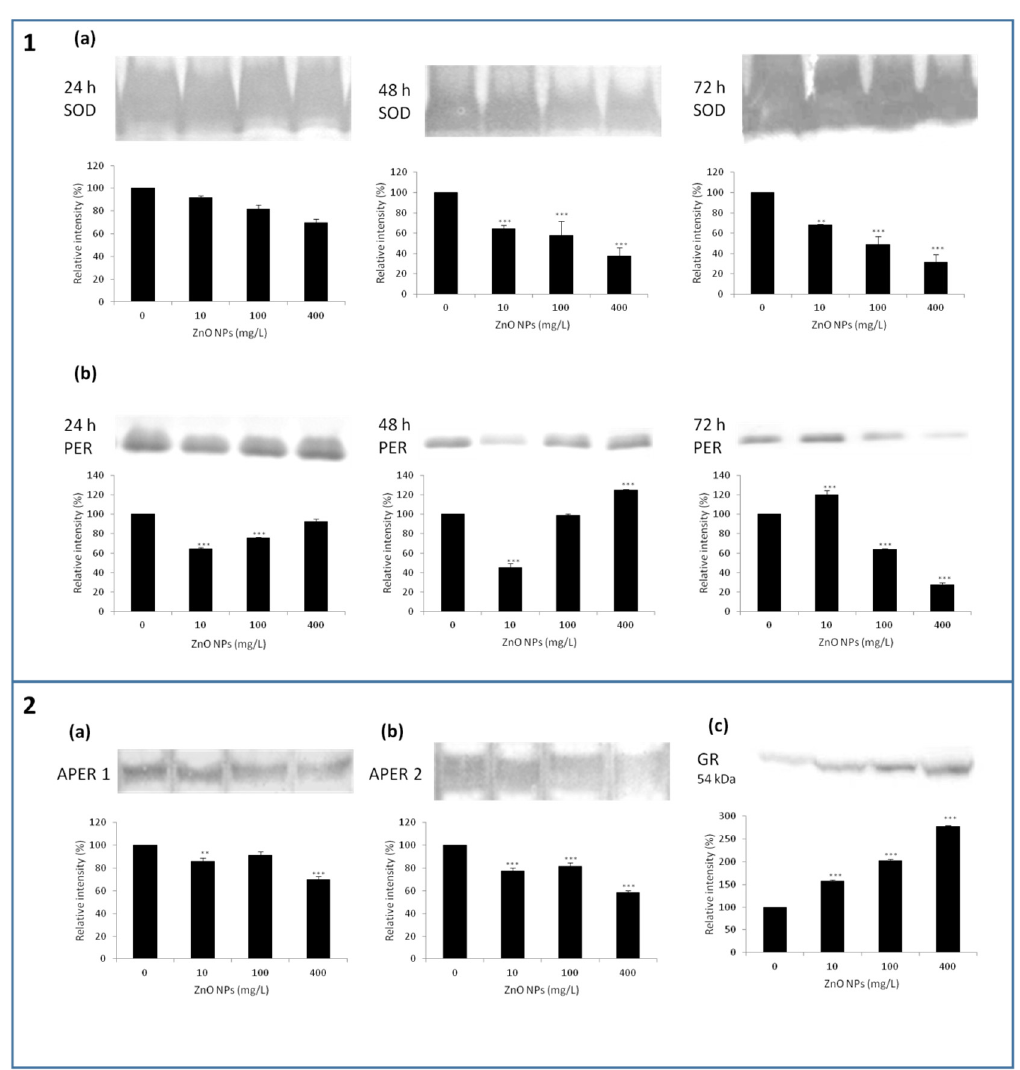
Figure 5. Time dependent response of tobacco BY-2 cells treated with ZnO NPs on superoxide dismutase, SOD ( 1a ) and peroxidase, PER ( 1b ) activities after 24, 48, and 72 h. The activity of two isoforms of ascorbate peroxidase, APER ( 2a , b ) and dose-dependent response of BY-2 cells treated with ZnO NPs after 72 h on the amount of glutathione reductase, GR ( 2c ) and. Each bar represents the mean of three independent experiments. * indicates a significant difference between the BY-2 cells treated with ZnO NPs and the corresponding control (untreated) BY-2 cells at p < 0.05, ** indicates a significant difference between BY-2 cells treated with ZnO NPs and the corresponding control (untreated) BY-2 cells at p < 0.01, *** indicates a significant difference between the BY-2 cells treated with ZnO NPs and the corresponding control (untreated) BY-2 cells at p < 0.001. Bars represent standard deviations. All the results were normalized against protein concentrations of the cell lysates taken from the same samples.